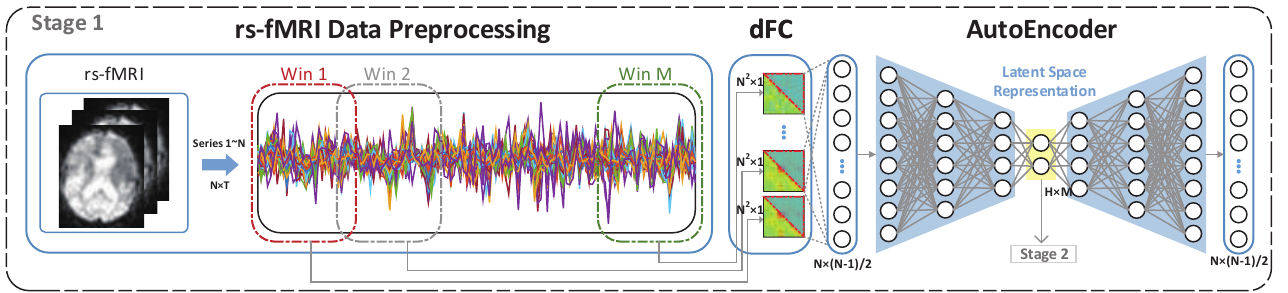
Figure 1. The main processes of the first stage of LSRNet training: (1) rs-fMRI pre-processing, (2) constructing the dFC, and (3) using a deep autoencoder to learn the dFC in order to obtain the latent space representation. In brief, we used the autoencoder to learn and extract the dFC high-level latent space representation.